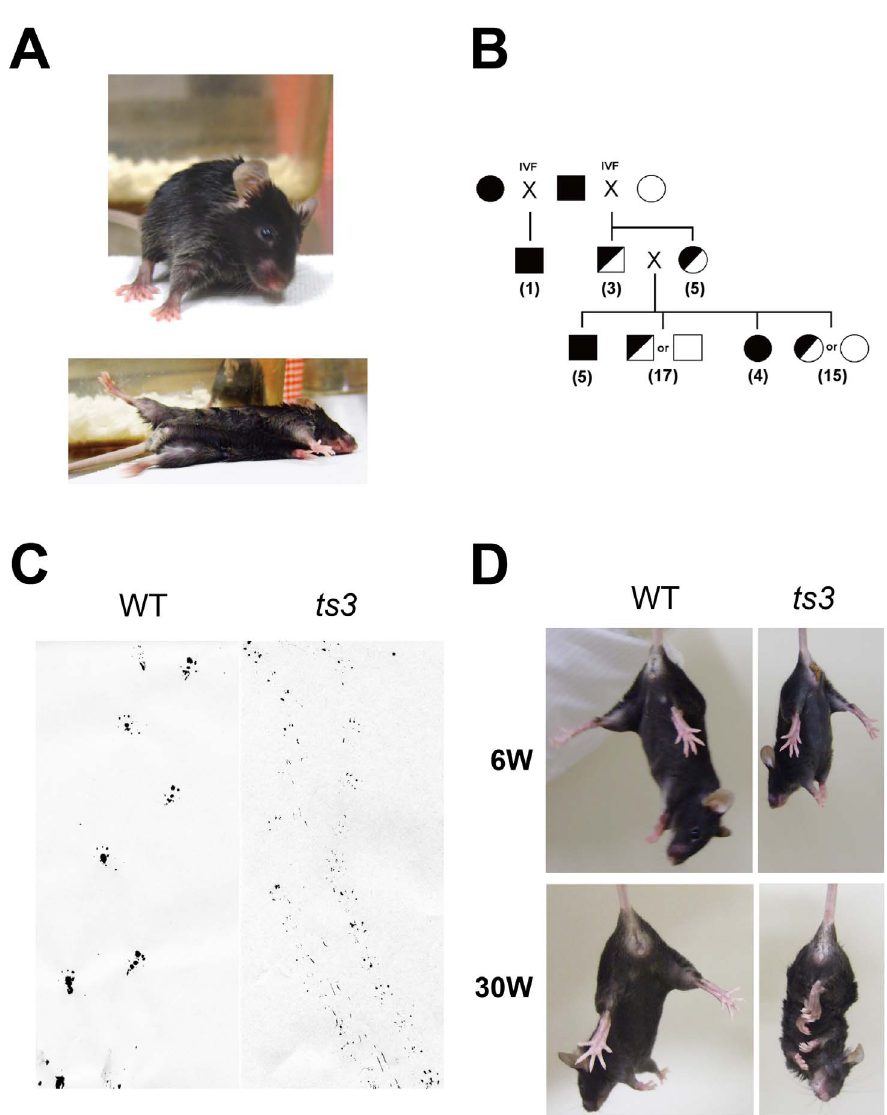
Figure 1. Isolation of a mouse line with behavioral abnormalities. A) Mutant mice fall frequently and display an inability to right themselves easily. B) Determination of hereditary pattern by IVF. Squares and circles indicate male and female, respectively. Black-fill indicates mice, possibly homozygote of the mutated allele, with behavior abnormalities. Half-filled and open symbols are presumed to be heterozygote and WT with normal behavior. Numbers indicate number of offsprings. C) Hind heel footprints for normal and mutant mice. D) Frequent limb-clasping displayed by older mice (30-week old).